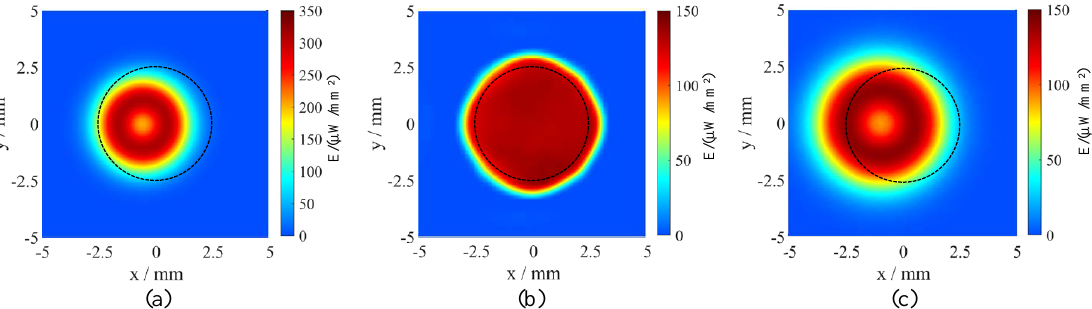
Figure 7. Irradiance over z = 12.5mm. ( a ) For the LD without any optics (LD). ( b ) For the LD with the hybrid TX-RX lens. ( c ) For fully separated TX and RX. The black circle highlights the anticipated TX FOV. Note the different color bar scales for the